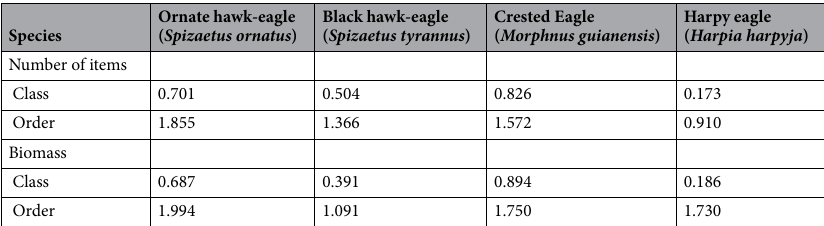
Table 1. Diet diversity of the four Neotropical eagles